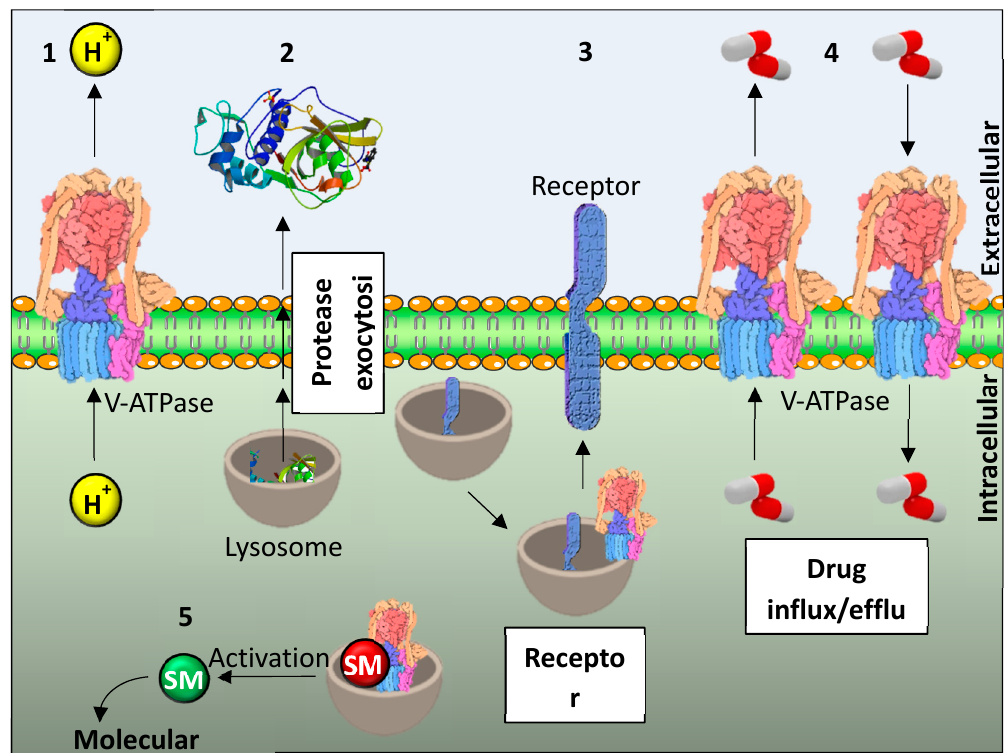
Figure 1. The roles of lysosomes and V-ATPase in cancer cells. ( 1 ) Protons produced by glycolysis (Warburg’s effect) are transported across the membrane from the cell by V-ATPase which prevents intracellular acidosis. ( 2 ) Proteases are activated in lysosomes and secretory vesicles and transported from the cell by exocytosis. Low extracellular pH in cancer microenvironment is optimal for their activity. Proteases are important for cancer cells invasiveness and angiogenesis. ( 3 ) Lysosomes and V-ATPase are important for receptor recycling. ( 4 ) Lysosomes are important for influx and efflux of different drugs. ( 5 ) Lysosomes and V-ATPase process signal molecules that regulate signal pathway. SM—signal molecule. The structures used in figure are vacuolar ATPase [Protein Data Bank (PDB) entry 5vox] and human cathepsin K (PDB entry 5J94).